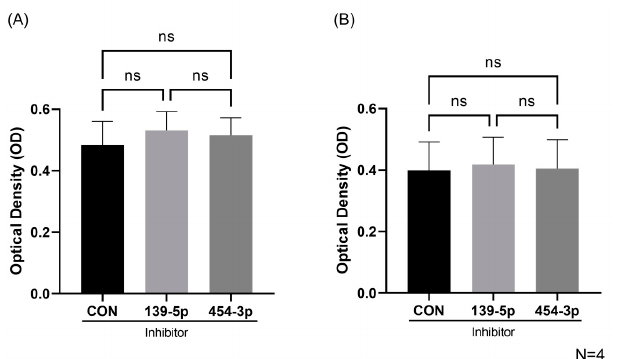
Figure 4. Viability and proliferation of HUVECs with miR-139-5p or miR-454-3p inhibition. ( A ) No significant differences were found in OD for HUVEC viability with miR-139-5p or miR-454-3p inhibitors compared with negative control inhibitors (CON) (N = 4). ( B ) No significant differences were found in OD for HUVEC proliferation with miR-139-5p or miR-454-3p inhibitors compared with negative control inhibitors (CON) (N = 4). ns: not significant.